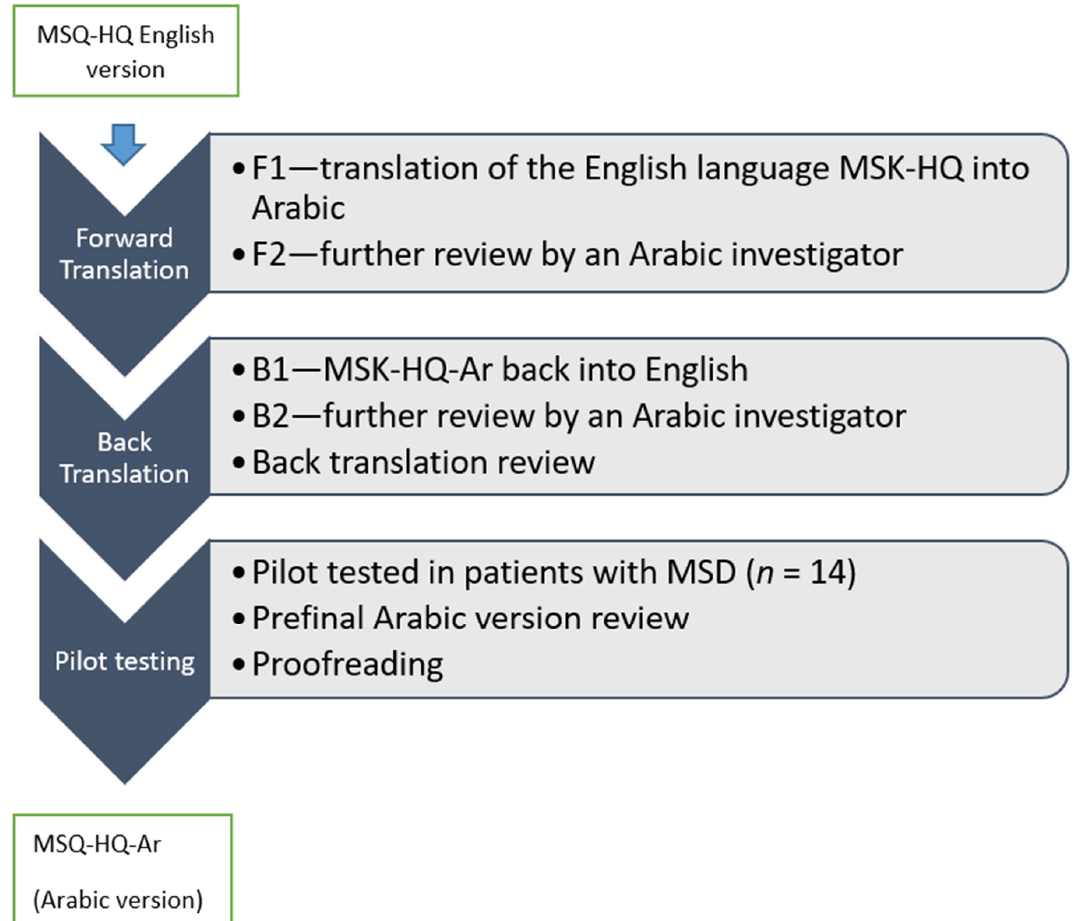
Figure 1. Flow chart for translation and cross-cultural adaptation of the Musculoskeletal Health Questionnaire into Arabic (MSK-HQ-Ar) from the English version. MSD, Musculoskeletal